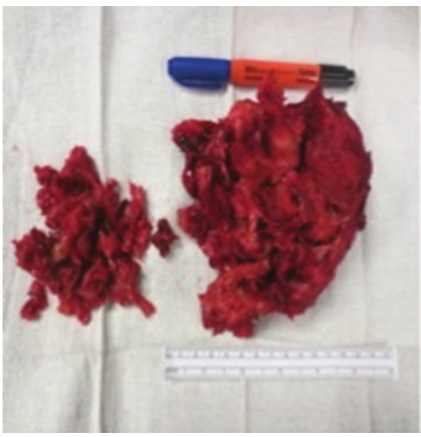
Figure 5: Gross image of the dissected pseudotumor. Figure 6: Revision total hip arthroplasty complicated by anterior dislocation.